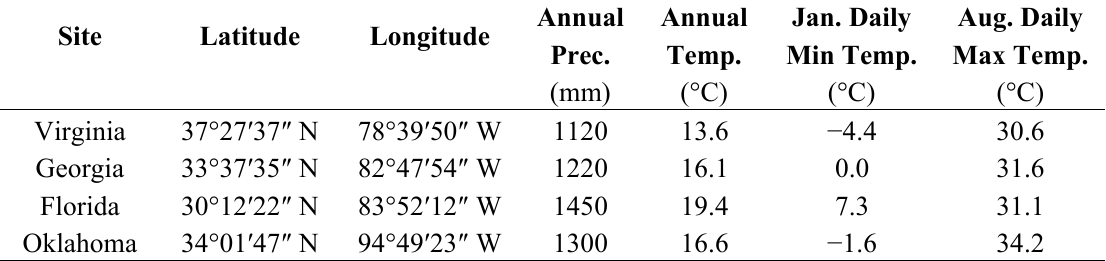
Figure 1. Map of the four throughfall reduction x fertilization study sites across the natural range of loblolly pine. Table 1. Location and climate information for the four throughfall reduction x fertilization study sites established in non-thinned, mid rotation loblolly pine plantations.